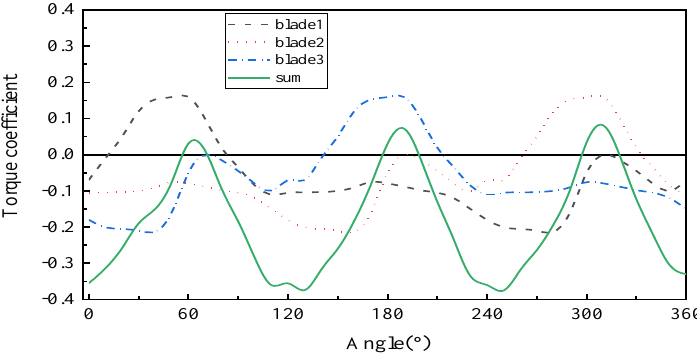
Figure 14. Tip speed ratio–wind energy utilization coefficient curve.